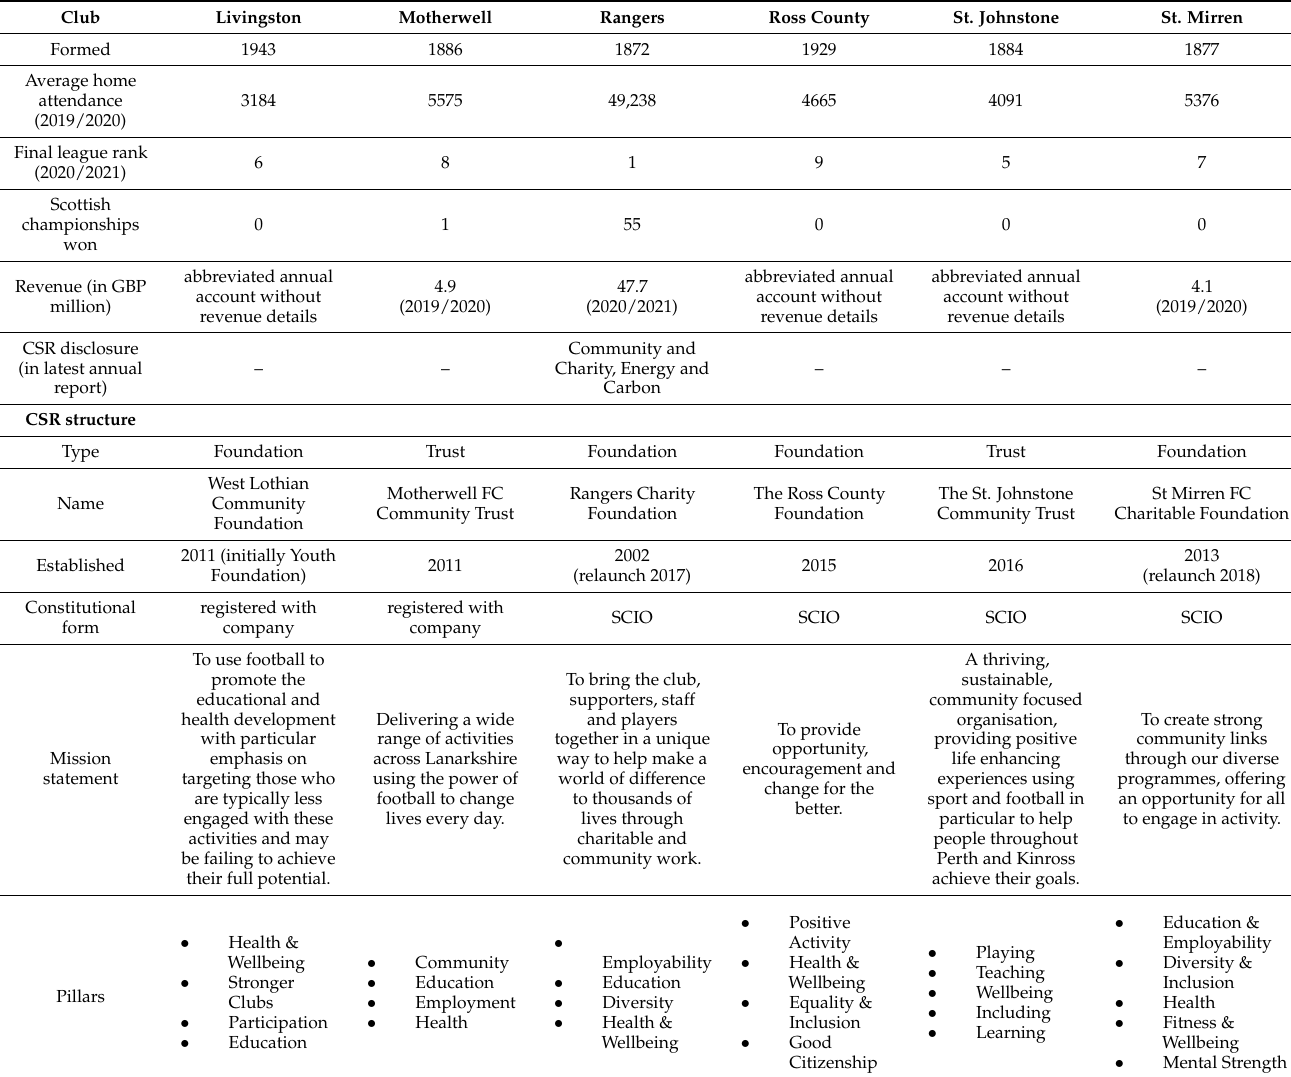
Table 4. Premiership clubs and their CSR structures—Part 2 (based on websites of clubs, their charities, OSCR, EFDN, SPFL Trust, Transfermarkt.de and annual